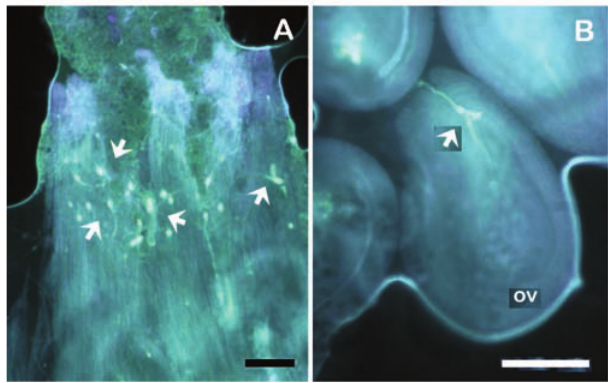
Fig. 8 - Fertilization of Moringa oleifera Lam (fluorescent light micrographs). A, pollen tube growing toward the style (arrows); B, ovules (ov) and pollen tube crossing the micropile and entering the embryo sac (arrows). Bars = A-B, 100 µm.